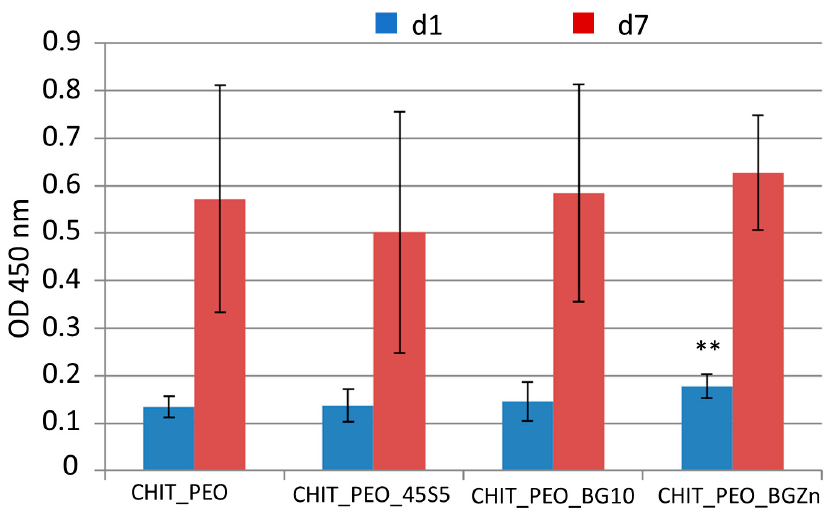
Figure 6. WST-8 assay: graph of OD at 450 nm for neat CHIT_PEO electrospun fibers and CHIT_PEO composite electrospun mats 1 and 7 days after seeding using bone murine stromal cells ST-2. ** p < 0.05 (ANOVA one way).